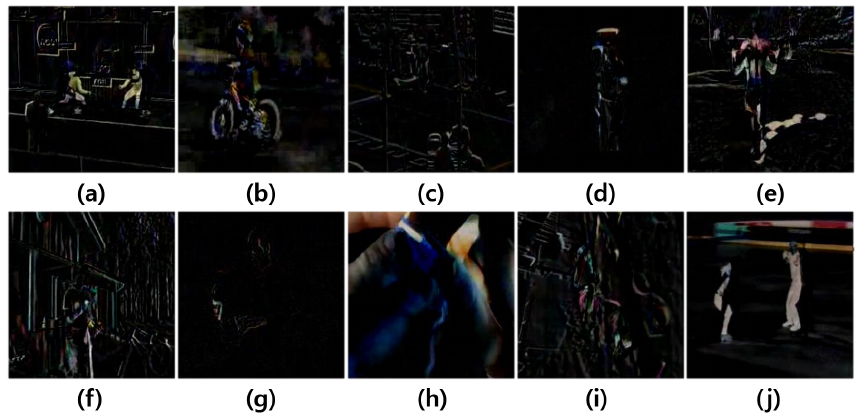
Figure 4. A set of differential images selected from UCF101 dataset: ( a ) fencing, ( b ) biking, ( c ) still rings, ( d ) pizza tossing, ( e ) lunge, ( f ) juggling balls, ( g ) mixing, ( h ) knitting, ( i ) rock climbing, and ( j ) ice